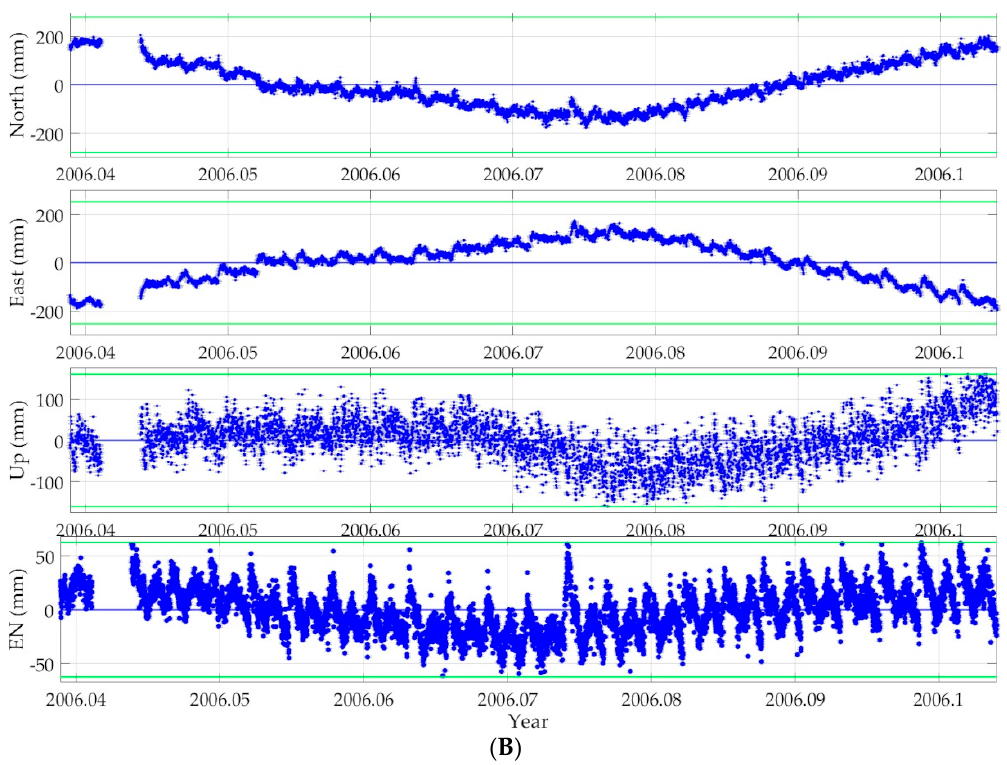
Figure 4. Detrended time series of DRY1 ( A ) and ICF1 ( B ) GNSS stations. The residuals of N, E, U, and horizontal EN components are evaluated removing the linear trend. The green horizontal lines show the bounds of 3-times the WRMS scatter of the residuals. For point DRY1, the response to the estimated ocean tide in the Up component is clear; concerning the signals evidenced by the North, East, and East-North plots, the increment in the horizontal ice flow velocity with the increment in the amplitude of the ocean tide pointed out by the horizontal component EN is clear.